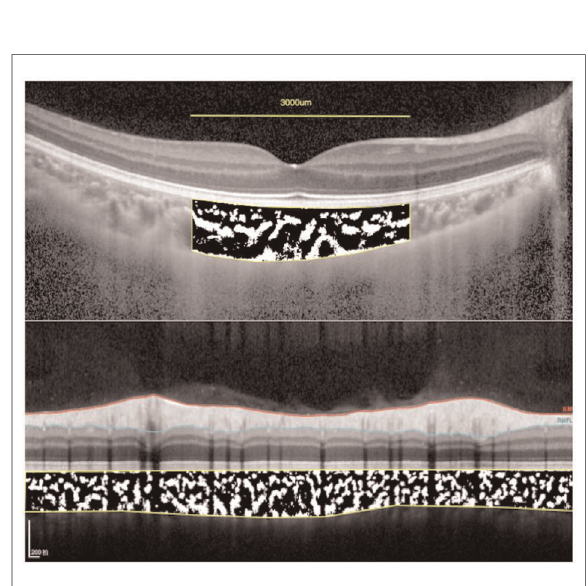
FIGURE 4 The subfoveal choroidal area and peripapillary choroidal area measurement. Using ImageJ software, the image was binarized with Niblack ’ s method, and the ratio of vascular area (black pixels) to stromal area (white pixels) was quanti fi ed.